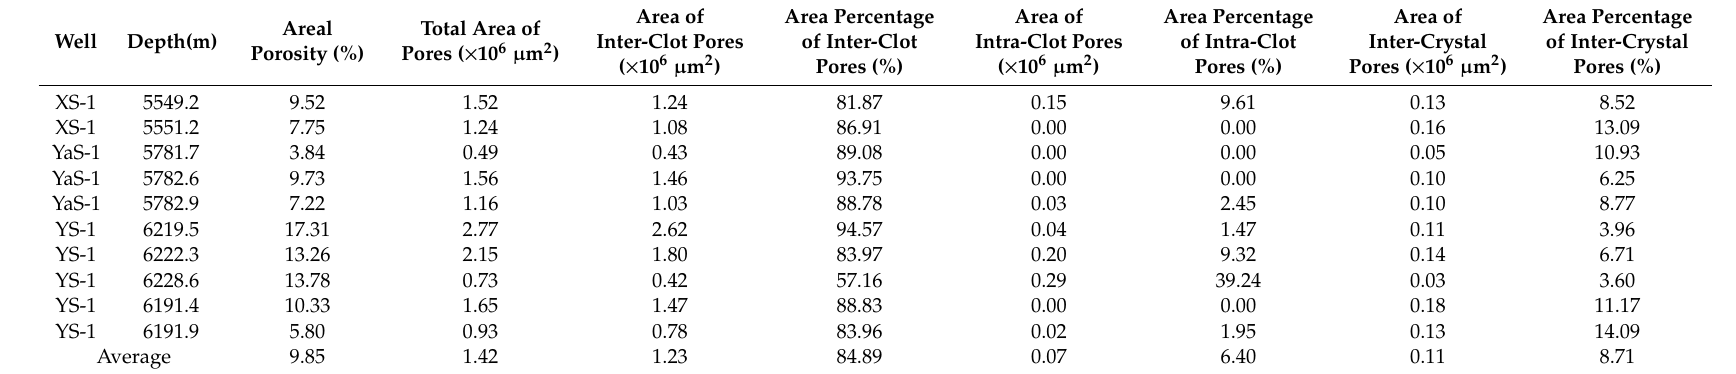
Table 2. Statistics of the area percentage of di ff erent types of pores in the fourth member of the Leikoupo Formation.